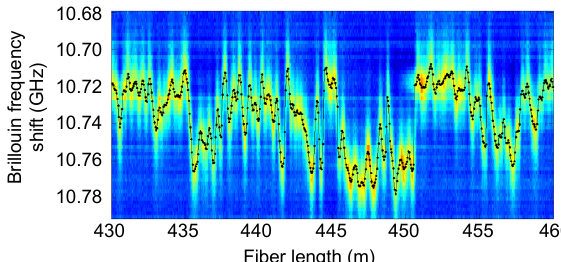
40a b Fig. 9 | ( a ) Extracted Brillouin frequency shift for different bending radii. ( b ) Dependence of BFS on curvature measured along an outer core of the MCF. The error intervals on the curvature and the meas- ured BFS are marked in green and purple triangle dots, respectively. Figure reproduced from ref. 25 , Optical Society of America.